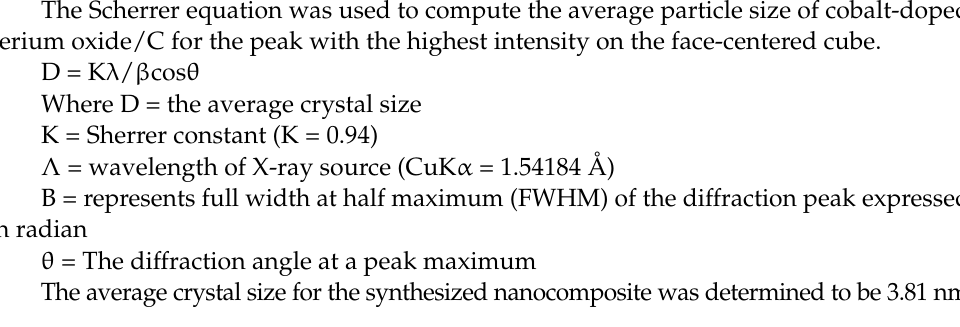
cerium oxide/C for the peak with the highest intensity on the face-centered cube.